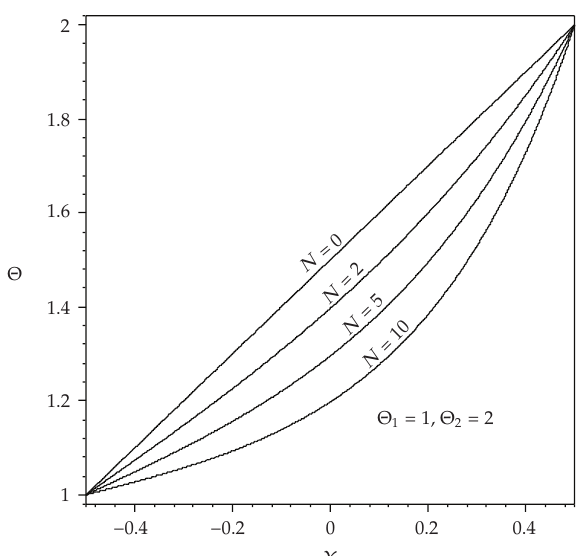
Figure 3: Temperature profiles for variations in the radiation parameter, N .